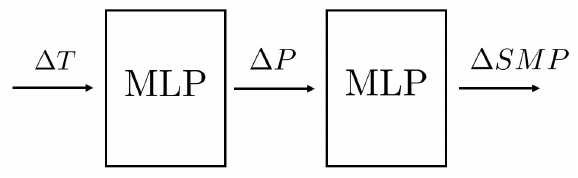
Figure 17. Relationship among ∆ T , ∆ P , and ∆ SMP .